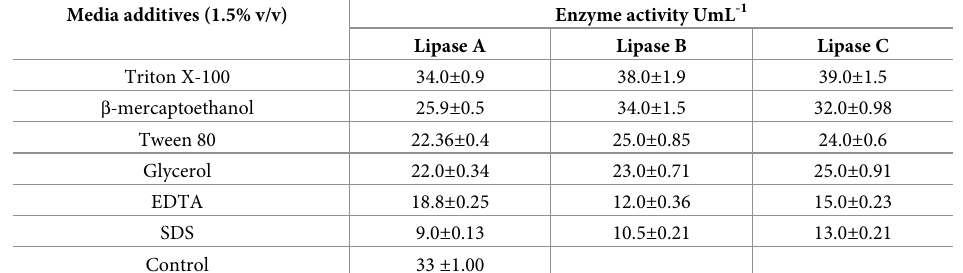
Table 5. Effect of media additives on lipase production from B . cereus NC7401 cultured using starch (Lipase A), maltose (Lipase B), and tryptone (Lipase